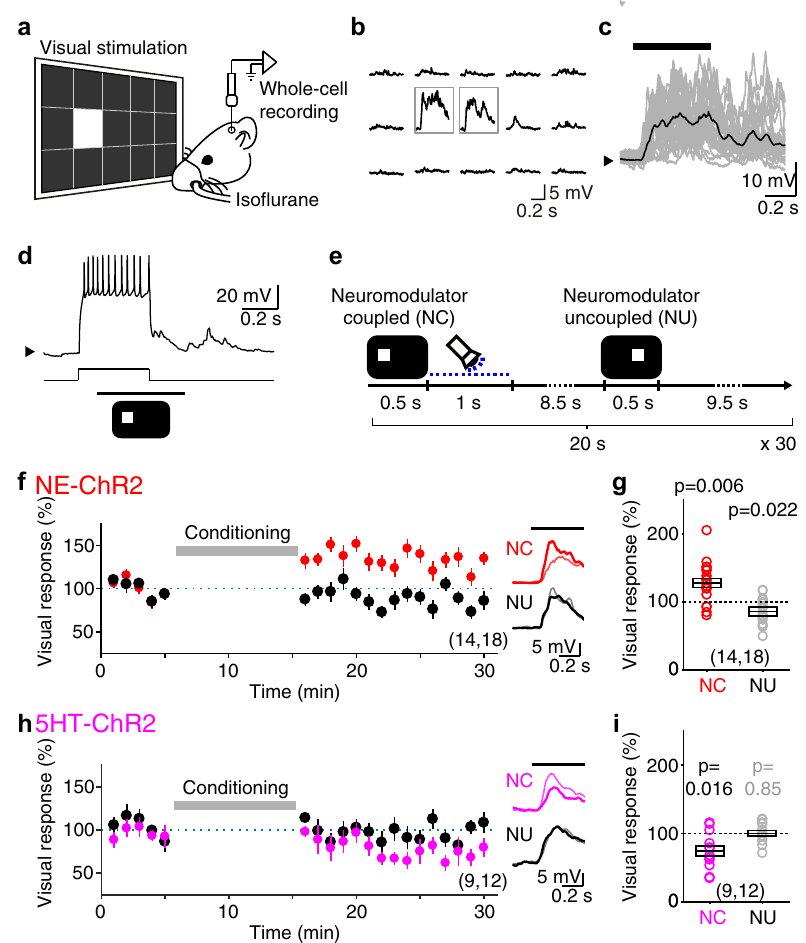
Fig. 3 Potentiation and depression of VEPSPs by Hebbian induction and optogenetic conversion of eligibility traces. a Schematic of in vivo whole-cell patch-clamp recording of the super fi cial V1 neurons. b Example of the VEPSPs elicited by visual stimuli at each subregion of a screen. Gray boxes indicate the two panels chosen for visual stimulation. c Individual (gray traces) and averaged (black trace) VEPSPs elicited by the visual stimulus presentation (black bar on top) of a representative neuron. Black arrow on the left indicates Vm ( − 70 mV). d Pairing of VEPSP with a burst of postsynaptic spikes. The current injected via recording pipette and the timing of visual stimulus are shown at the bottom. Black arrow on the left indicates Vm ( − 70 mV). e Visual conditioning protocol. f Normalized change of the NC (red) or NU (black) VEPSP amplitude of the NE-ChR2 mice by the visual conditioning. Inset traces show the VEPSPs of a representative neuron averaged initial (thin line) or last (thick line) 5 min of the recording. g Summary of VEPSP changes by the visual conditioning. Box plot: average ± s.e.m. Sample number indicates the number of animals and the number of recorded neurons. h , i Same as panel ( f , g ) but for the 5HT-ChR2 mice. Source data are provided as a Source Data